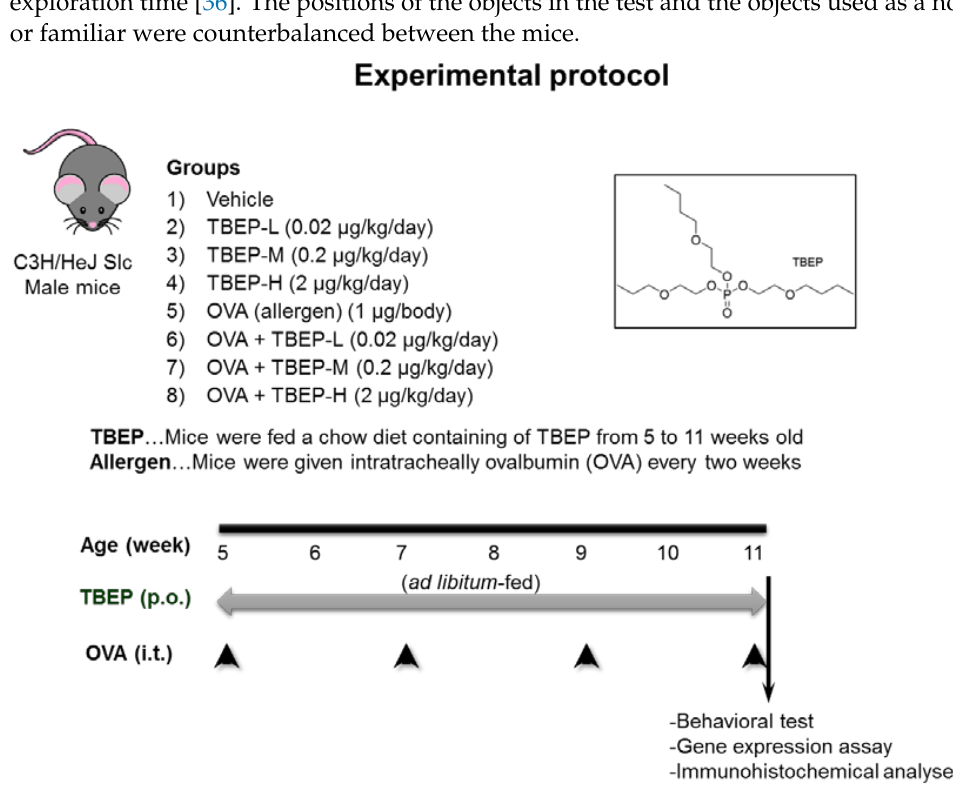
Figure 10. Experimental protocol. Five-week-old mice were allotted into eight groups as follows: (1) vehicle, (2) 0.02 µ g/kg/day TBEP (TBEP-L), (3) 0.2 µ g/kg/day TBEP (TBEP-M), (4) 2 µ g/kg/day TBEP (TBEP-H), (5) ovalbumin (OVA), (6) OVA + TBEP-L, (7) OVA + TBEP-M, and (8) OVA +TBEP-H. Each group contains 5 to 6 mice. TBEP was added to mouse chow for dietary exposure. Once every two weeks, the mice were given intratracheal instillation of 1 μg of OVA. At 11 weeks of age, a novel object recognition test was performed. Then, the hippocampi were collected to detect neurological and immunological molecular markers.